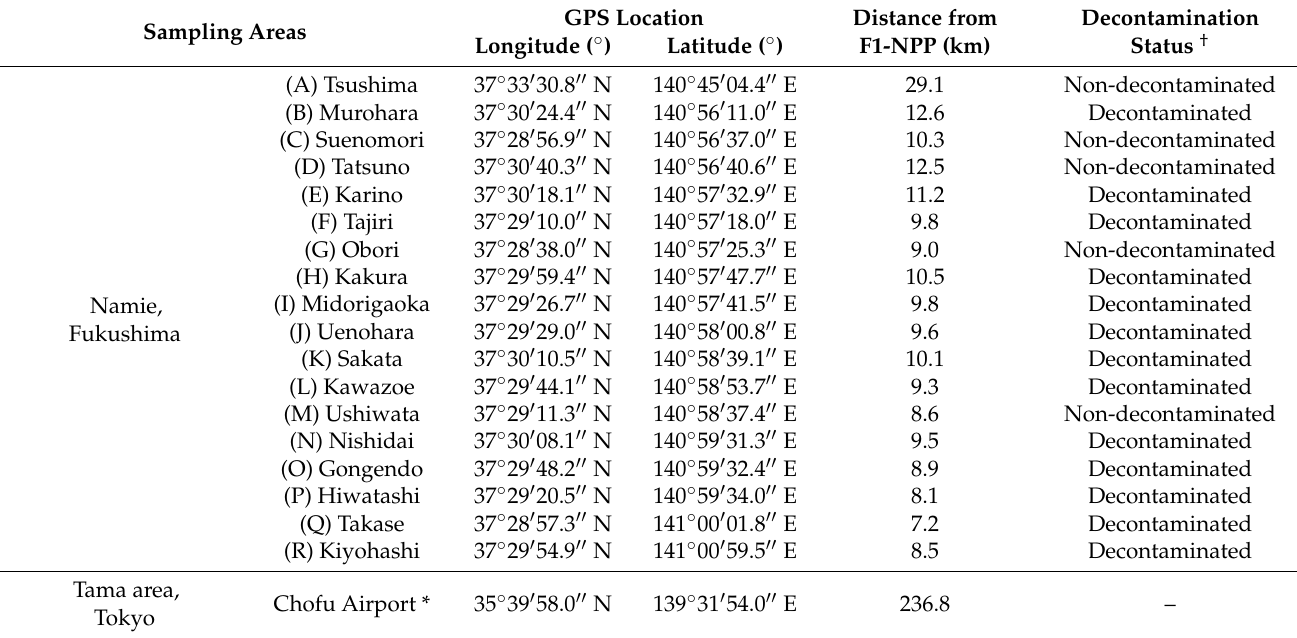
Table 1. Locations and decontamination status of sampling